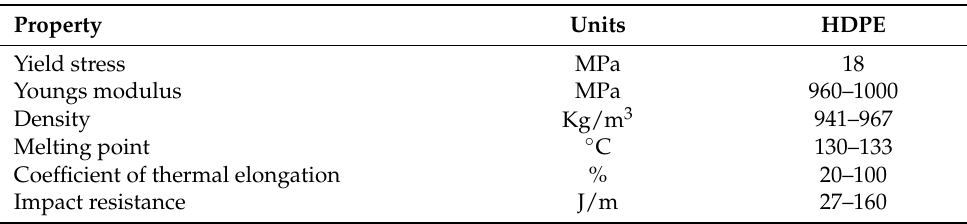
Table 1. Properties of HDPE [20].